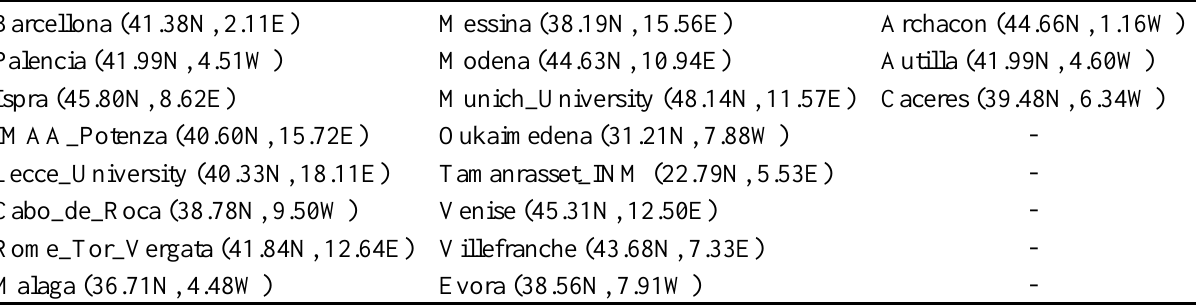
Table 1. AERONET sites used in dust detection and retrieval validation.